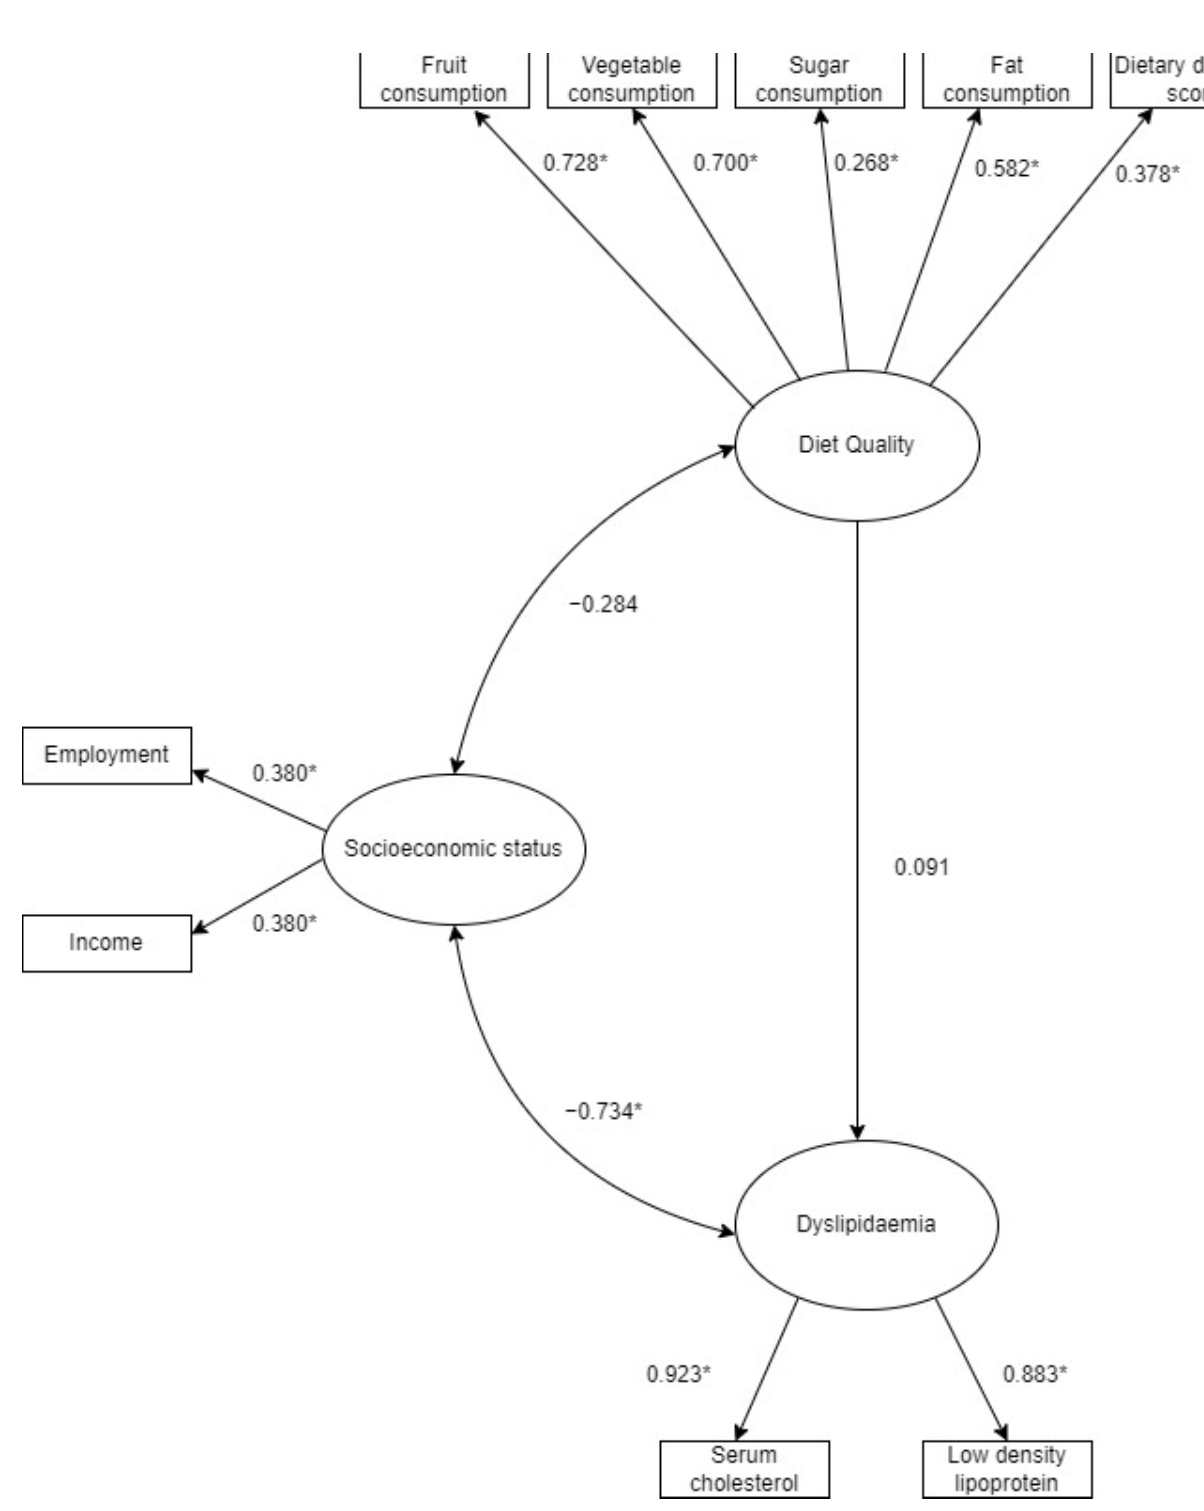
Figure 2. Structural equation model of the relationship between diet quality, socioeconomic status and dyslipidaemia in children. * Statistical significance = p < 0.05.